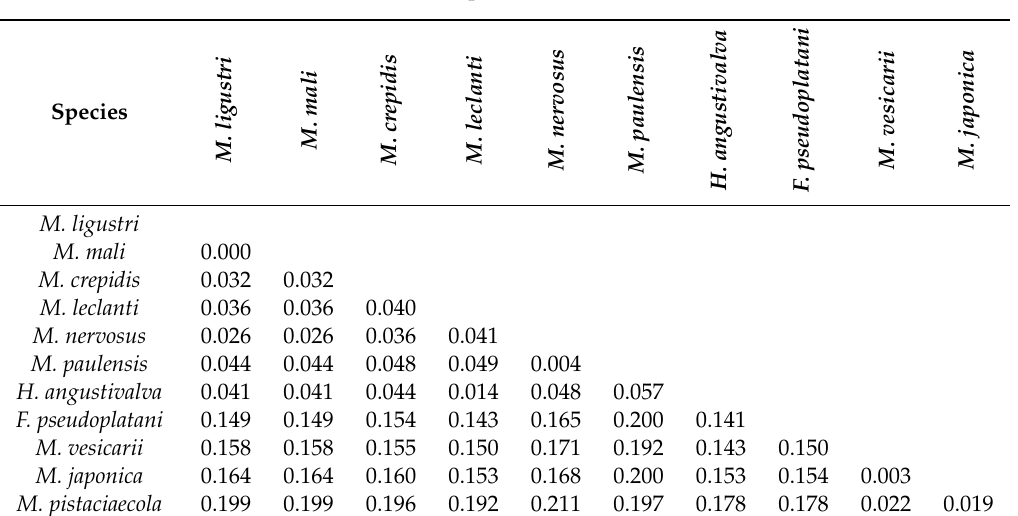
Table 3. Genetic distances between species of Monoctonina based on 28S rDNA .